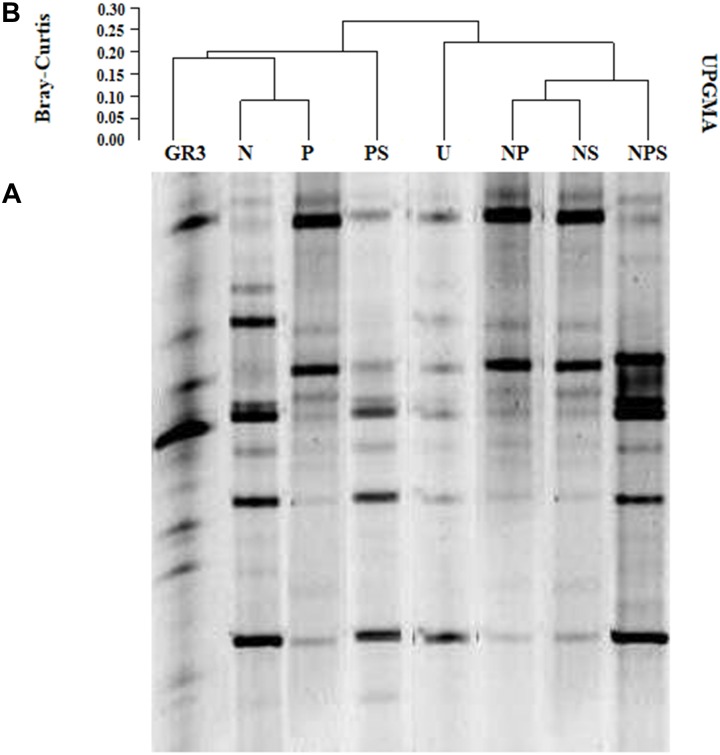
Denaturing gradient gel electrophoresis of microcosm samples. DGGE patterns of bacterial communities from microcosms with various amendments (A) and Bray–Curtis cluster analysis among the DGGE band patterns (B). No amendment control (U) was also included. For Bray–Curtis analysis presence or absence of bands at corresponding positions was considered.